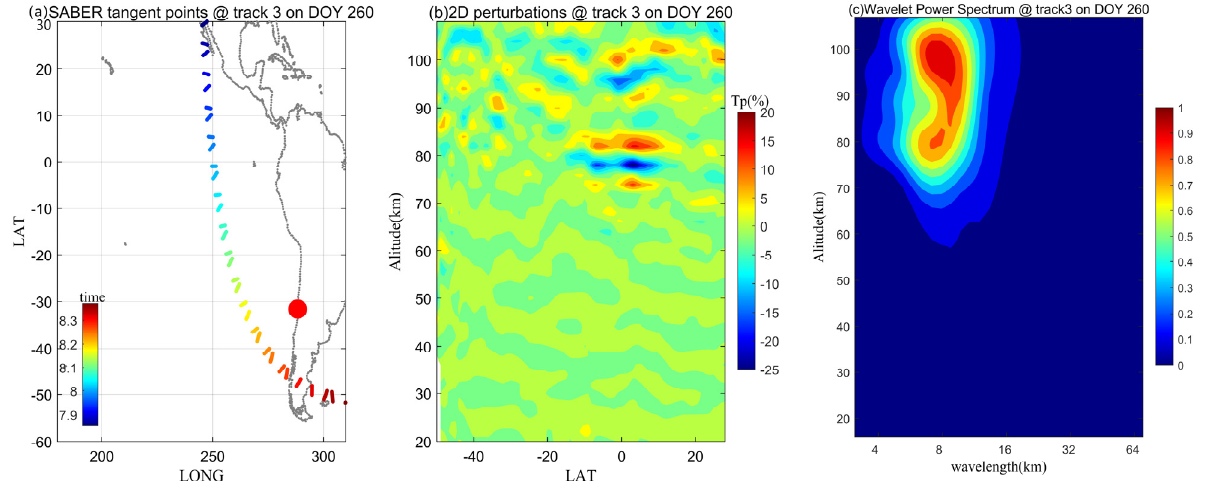
Figure 11. ( a ) The projection of the tangent points of track 3 on DOY 260 of 2015. The color denotes the observation time. ( b ) SABER temperature perturbations that are made by a 2 − D cubic interpolation in altitude and latitude over the coherent variations of limb scans of track 3. ( c ) The corresponding wavelet power spectrum of track 3.